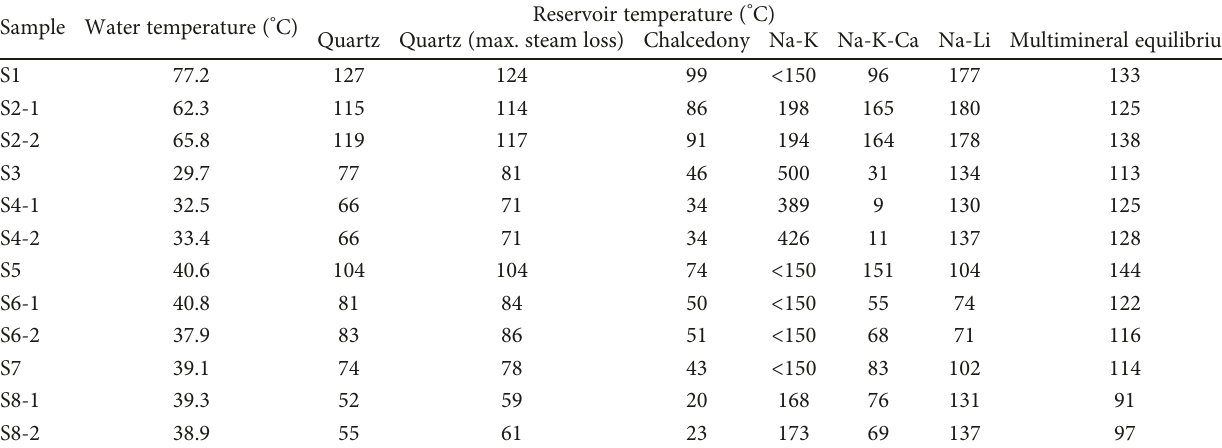
Table 3: Estimated reservoir temperatures of the hot springs in the Simao Basin.